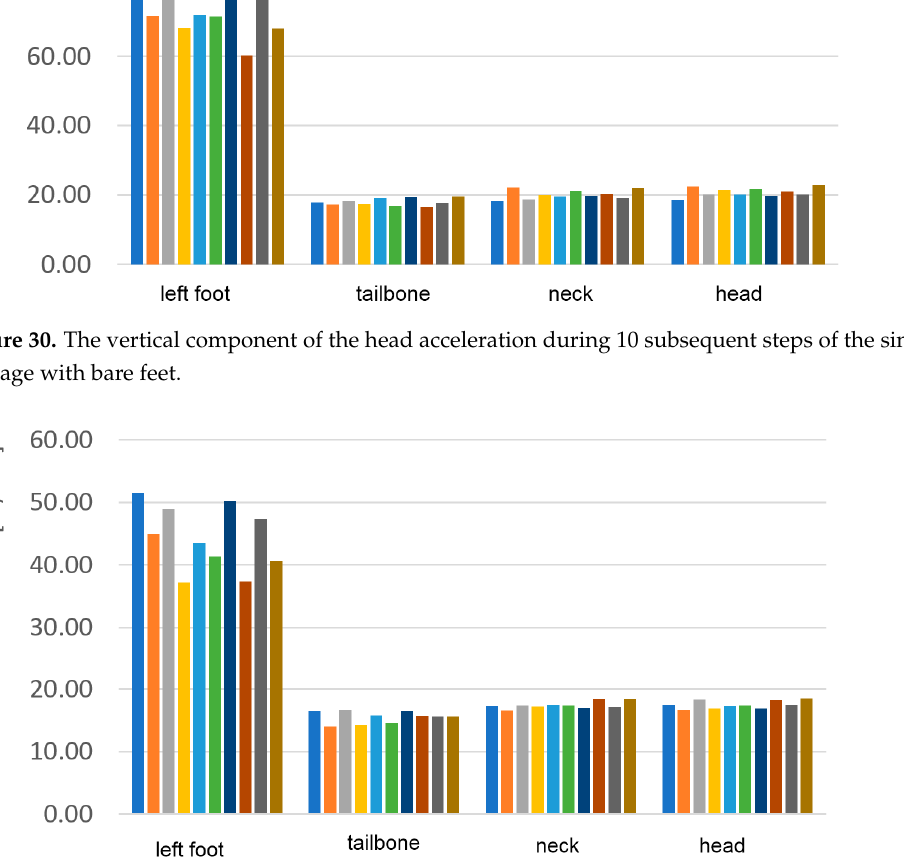
Figure 31. The vertical component of the head acceleration during 10 subsequent steps of the single passage in sports shoes.